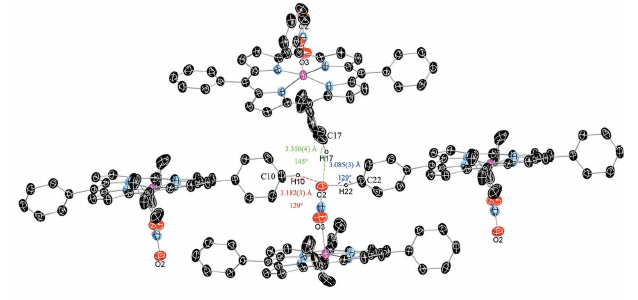
Figure 4 C—H (cid:2)(cid:2)(cid:2) O hydrogen-bonding interactions between adjacent porphyrin molecules (dashed lines).